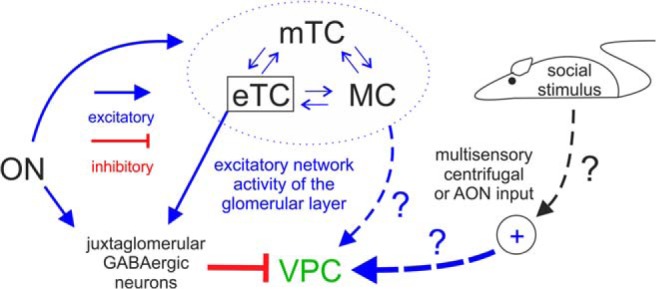
Graphic summary of detected inputs to olfactory bulb VPCs. Blue arrows represent excitatory inputs indicated by this study and from the literature. Red lines represent inhibitory inputs indicated by this study. The strength of the lines indicates the strength of the input. The cells within the dashed blue circle indicate the excitatory network within the same home glomerulus. Arrows labeled with question marks indicate speculative excitatory inputs to VPCs.